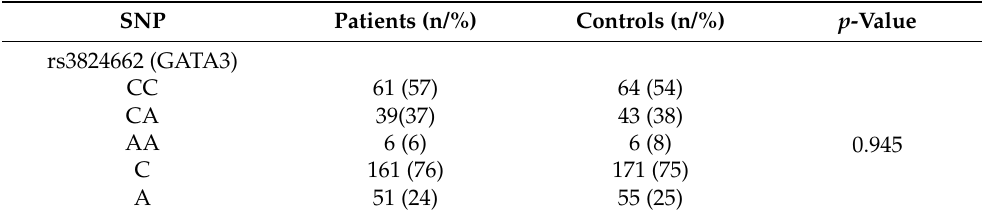
Table 4. Distribution of genotypic and allelic frequencies of the GATA3 SNP in MS patients and